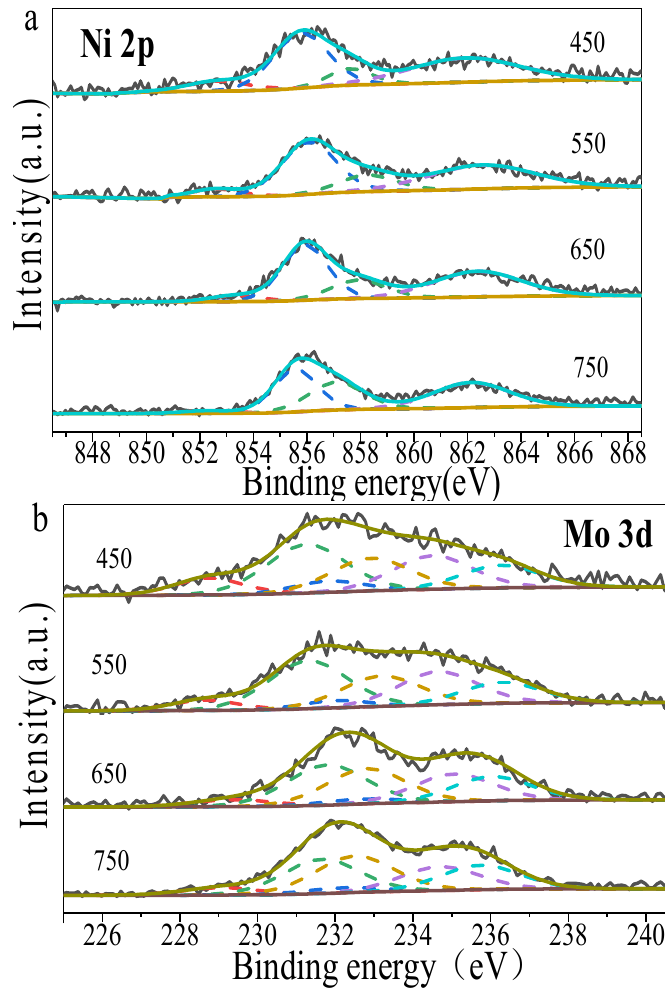
Figure 10. XPS spectra of ( a ) Ni 2p and ( b ) Mo 3d of Ni 10 Mo 10 Al catalysts after calcination at 450–750 °C. Table 4. Quantitative Ni 2p and Mo 3d XPS analysis for reduced Ni 10 Mo 10 Al catalysts after calcina- tion at 450–750 °C a .